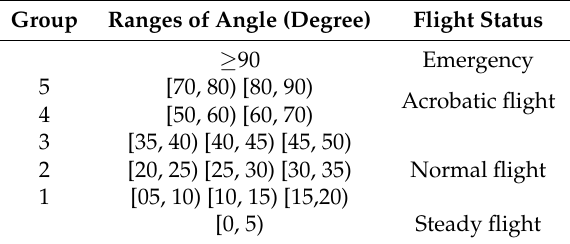
Table 1. Division of angle range in each flight